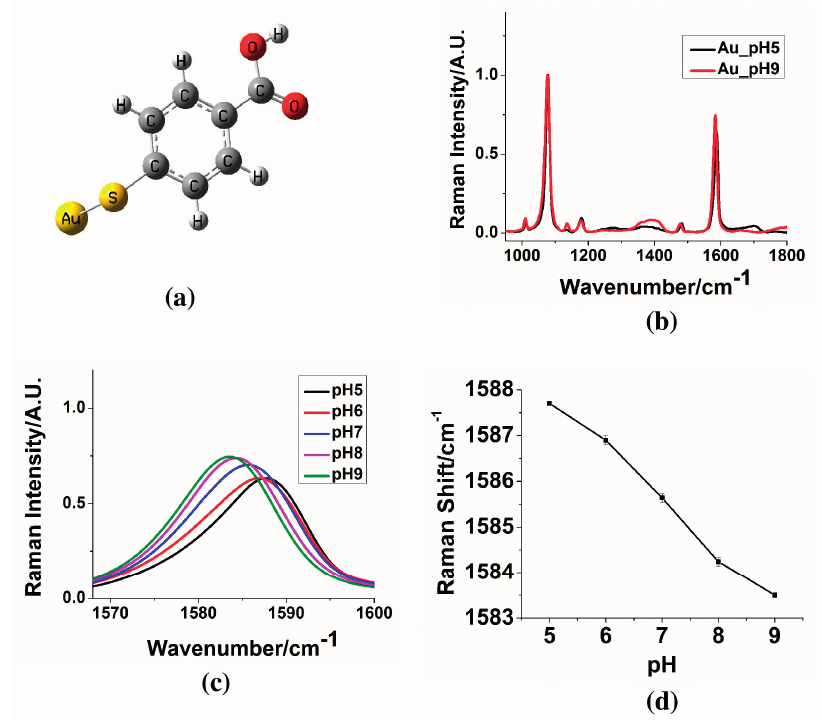
Figure 2. ( a ) pMBA-Au complex structure used for density functional theory (DFT) calculations; ( b ) Surface enhanced Raman scattering (SERS) spectra comparison obtained from pH sensing AuNSs nanoprobes at pH 5 and 9. The spectrum is normalized with intensity at 1078.3 cm − 1 ; ( c , d ) SERS peak position shift between pH 5 and 9 [27]. (Adapted from Ref.